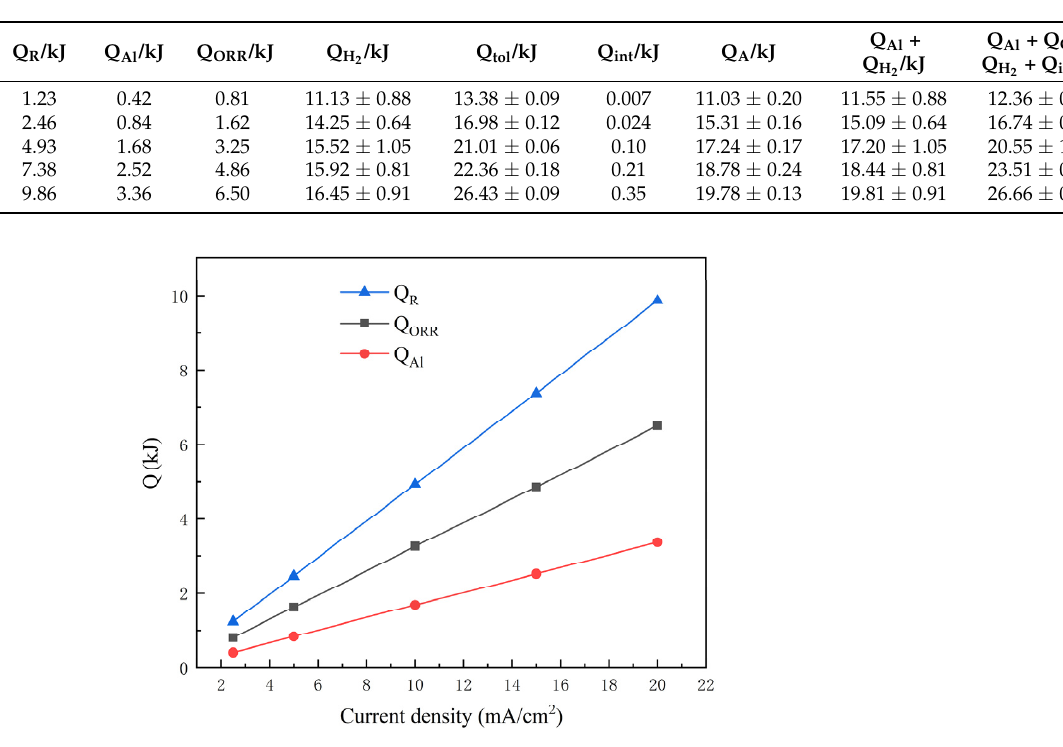
Table 2. Heat production for each part at different discharge current densities.